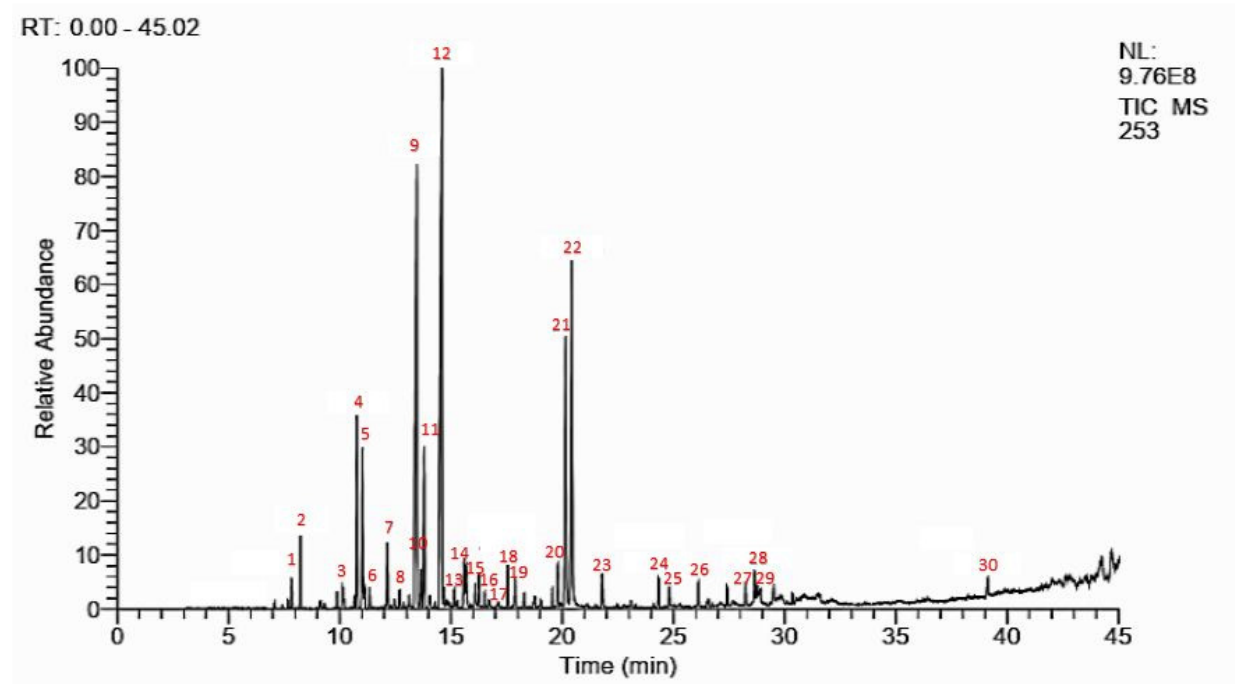
Figure 1. GCMS chromatographic profile of W. frutescens EO.